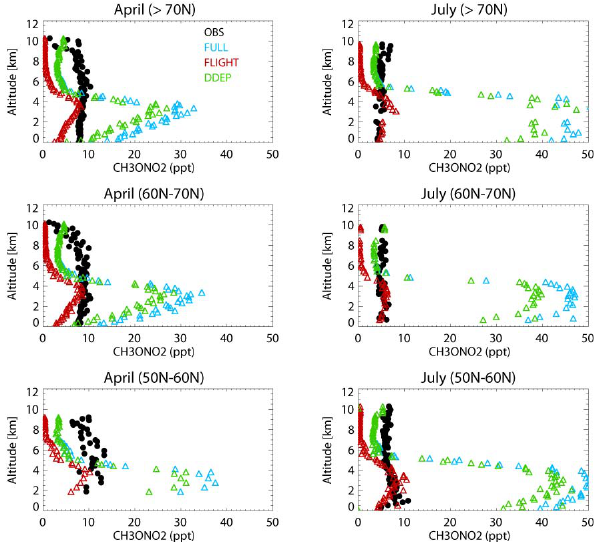
Fig. 9. A comparison of the vertical distribution of CH 3 ONO 2 around Alaska (April) and Western Canada (July) as measured dur- ing 2008 during the ARCTAS measurement campaign and as sim- ulated in TM5. Comparisons are shown for FULL (light blue), FLIGHT (red) and DDEP (green).